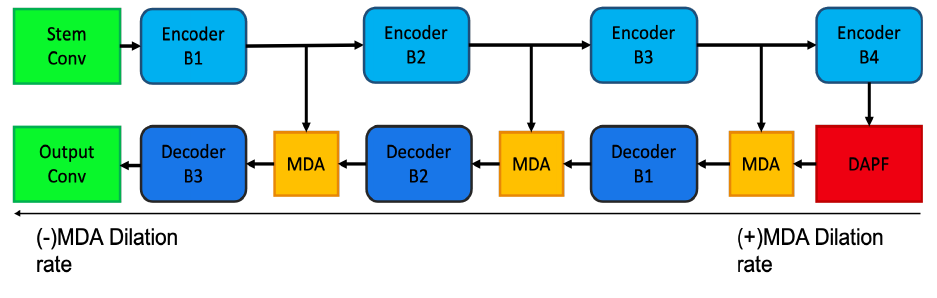
Figure 1. FASSD-NET architecture.